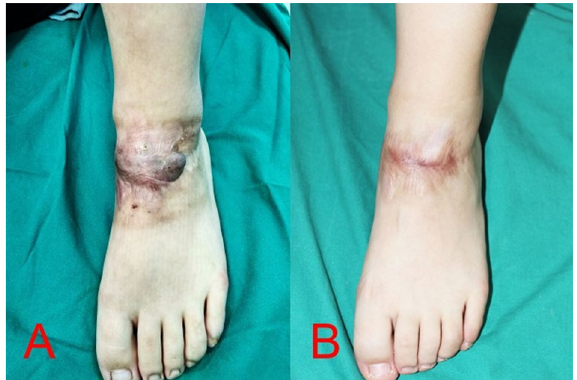
Figure 3. An 18-years-old girl [case 7] sustained a keloid scar post traumatic injury on the dorsum of her left foot for the duration of 1 year ( A ); post two sessions using intralesional 1470 nm bare-fibre diode laser ( B ).